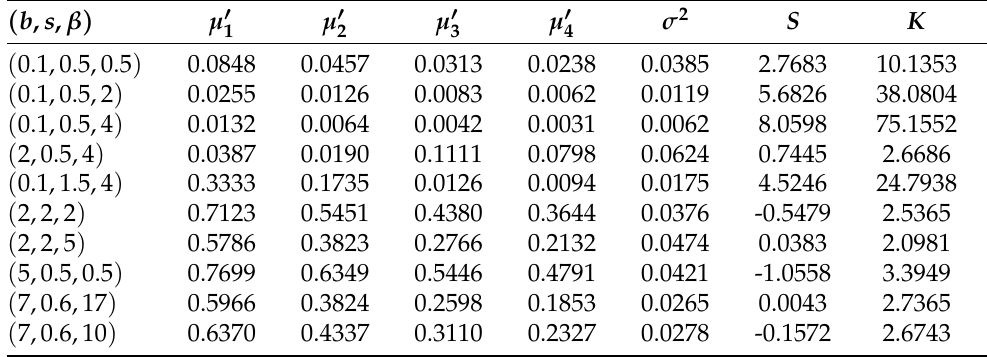
Table 1. The values of some moment measures for the UG/G distribution for several values of b , s , and β